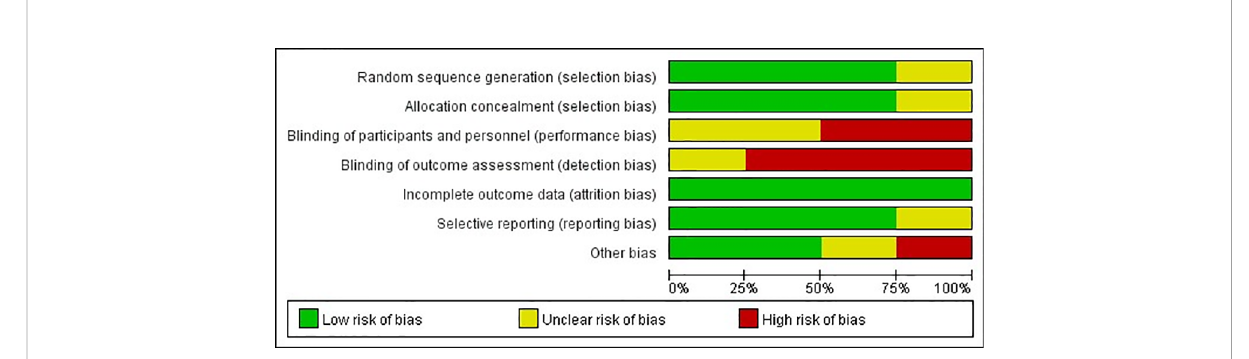
FIGURE 2 Risk of bias graph: review authors ’ judgments about each risk of bias item presented as percentages across RCTs.